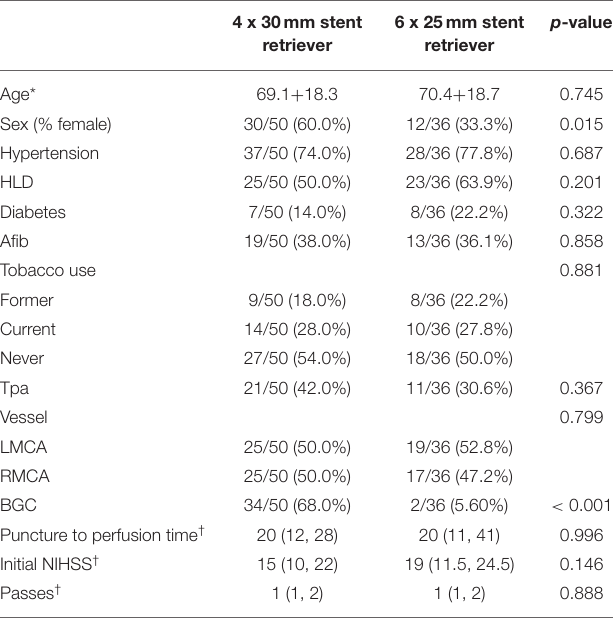
TABLE 1 | Demographic and clinical